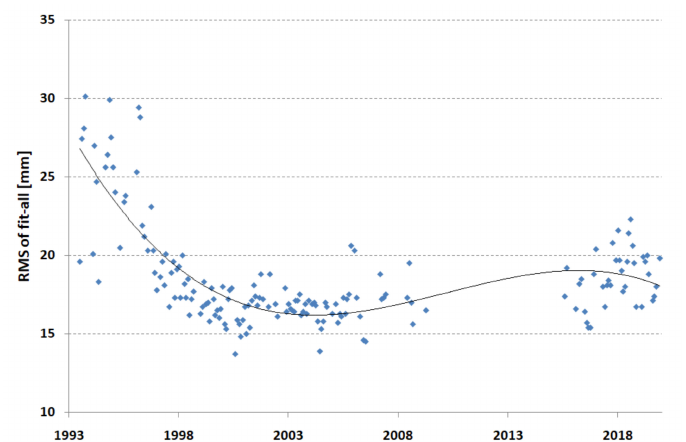
Figure 1. RMS of fit for all core stations (monthly